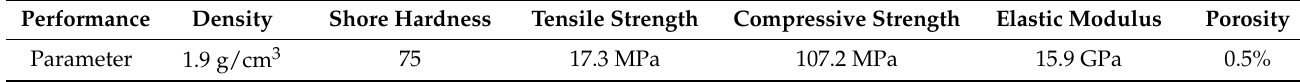
Figure 1. Orthogonal cutting experiment device that ( a ) is clamping method and ( b ) is the schematic drawing of tool. Table 2. Mechanical properties of graphite/polymer composites.